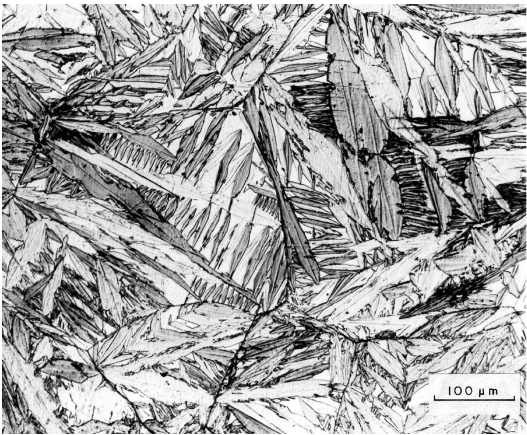
Fig. 2 - Light micrograph showing the microstructure of a coarse-grained austenite of a Fe-31wt%Ni-0.02wt%C alloy transformed by cooling into liquid nitrogen. (Courtesy of J. R. C. Guimarães)